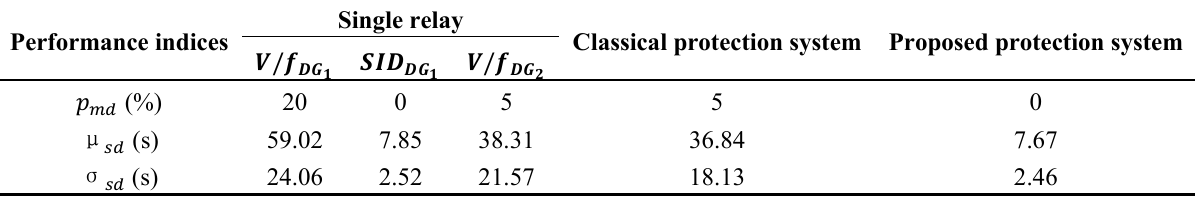
Table 9. Comparison between the classical and the proposed protection systems in the Case C. Performance